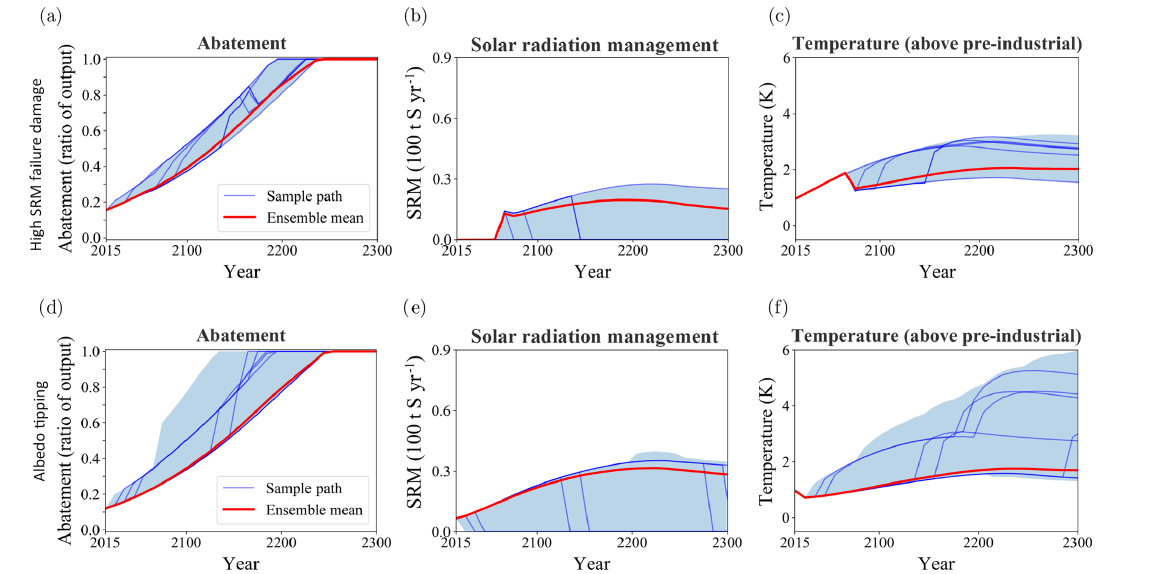
Figure 5. Policy and temperature for the “SRM as insurance” scenarios (see Sect. 3.4). The top row shows the scenario with high damage in case of SRM failure, while the bottom row shows the scenario with an albedo tipping point. The left column (a, d) show abatement, the middle one (b, e) SRM, and the right (c, f) warming. The thin blue lines represent a sample of individual ensemble members, the thick red line the ensemble mean, and the blue shaded area indicates the range of possible values in the whole